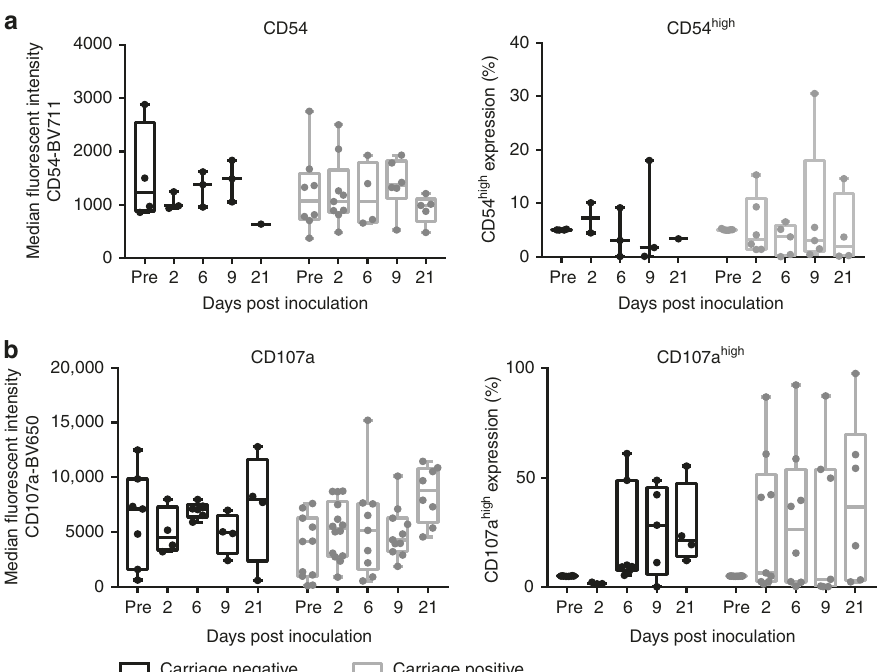
Fig. 2 Epithelial surface marker expression in vivo is unaltered during colonisation of S. pneumonia . Epithelial cells from nasal curette biopsies were analysed by fl ow cytometry for a CD54 and b CD107a. Results were expressed as median fl uorescence intensity (left) and high cell surface expression ( ≥ 95% of the baseline expression, right) representing at least two volunteers per time point who were carriage negative (black) and carriage positive (grey). Comparisons between carriage negative and carriage positive, on each day of sampling, was analysed by one-way ANOVA ( a — parametric, b — non- parametric). P = 0.84 CD54 MFI; P = 0.98 CD54 %; P = 0.09 CD107a MFI; P = 0.10 CD107a %. Boxplots represent the median (centre line) and interquartile range (box), minimums and maximums